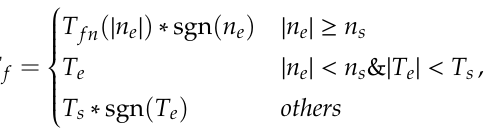
Figure 8. Ship propulsion model in Simulink.